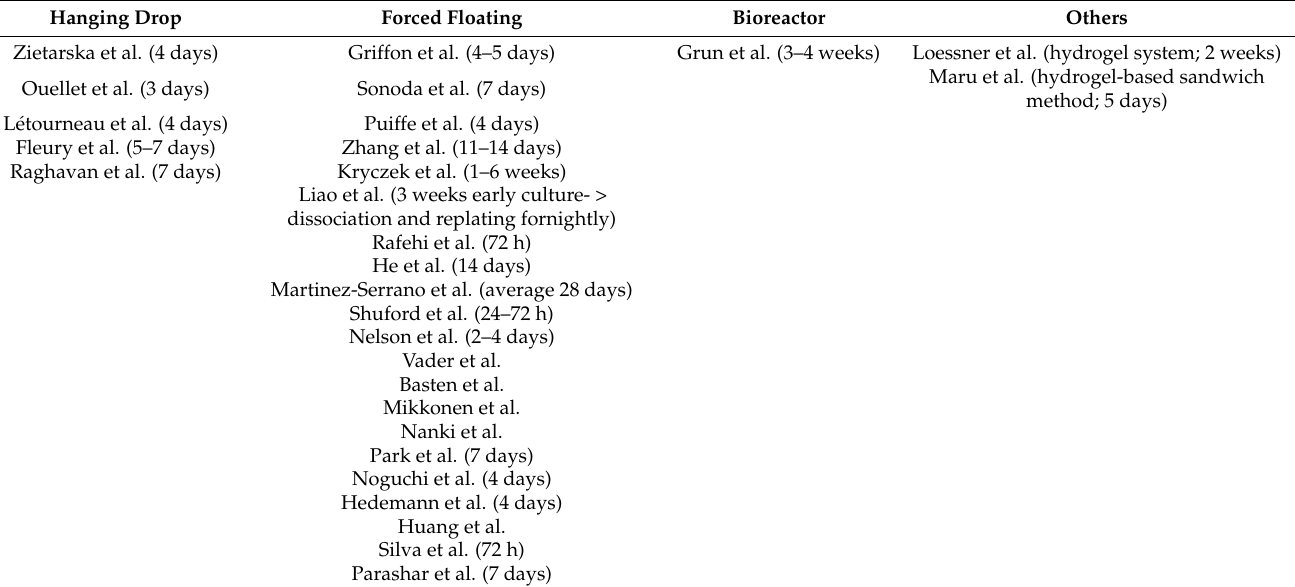
Table 4. Summary of methods used to originate 3D structures from patient derived